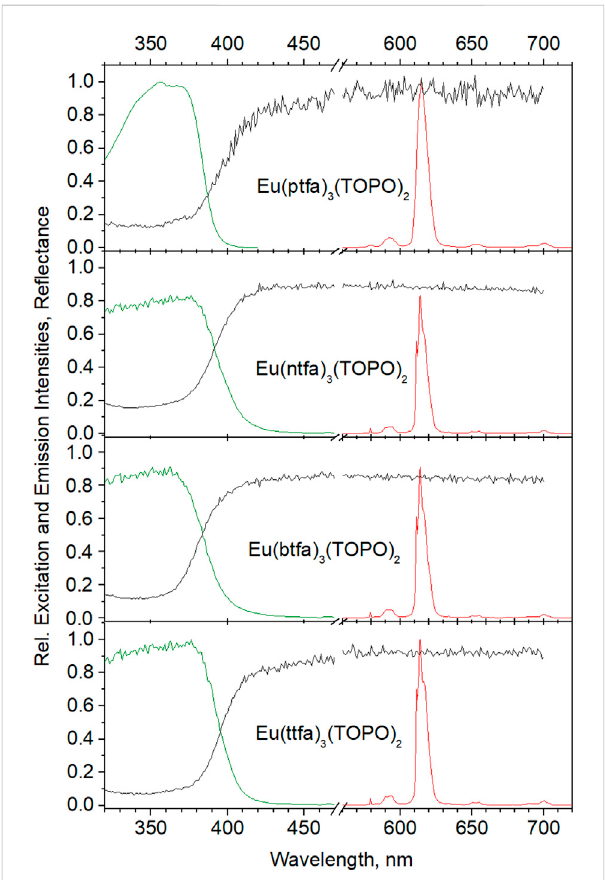
FIGURE 4 Re fl ectance, excitation and emission spectra of Eu(diketonate) 3 (TOPO) 2 complexes in polystyrene beads, syntheses carried out with 10% wt relative to styrene. Spectra are normalized relative to Eu(ttfa) 3 (TOPO) 2 .